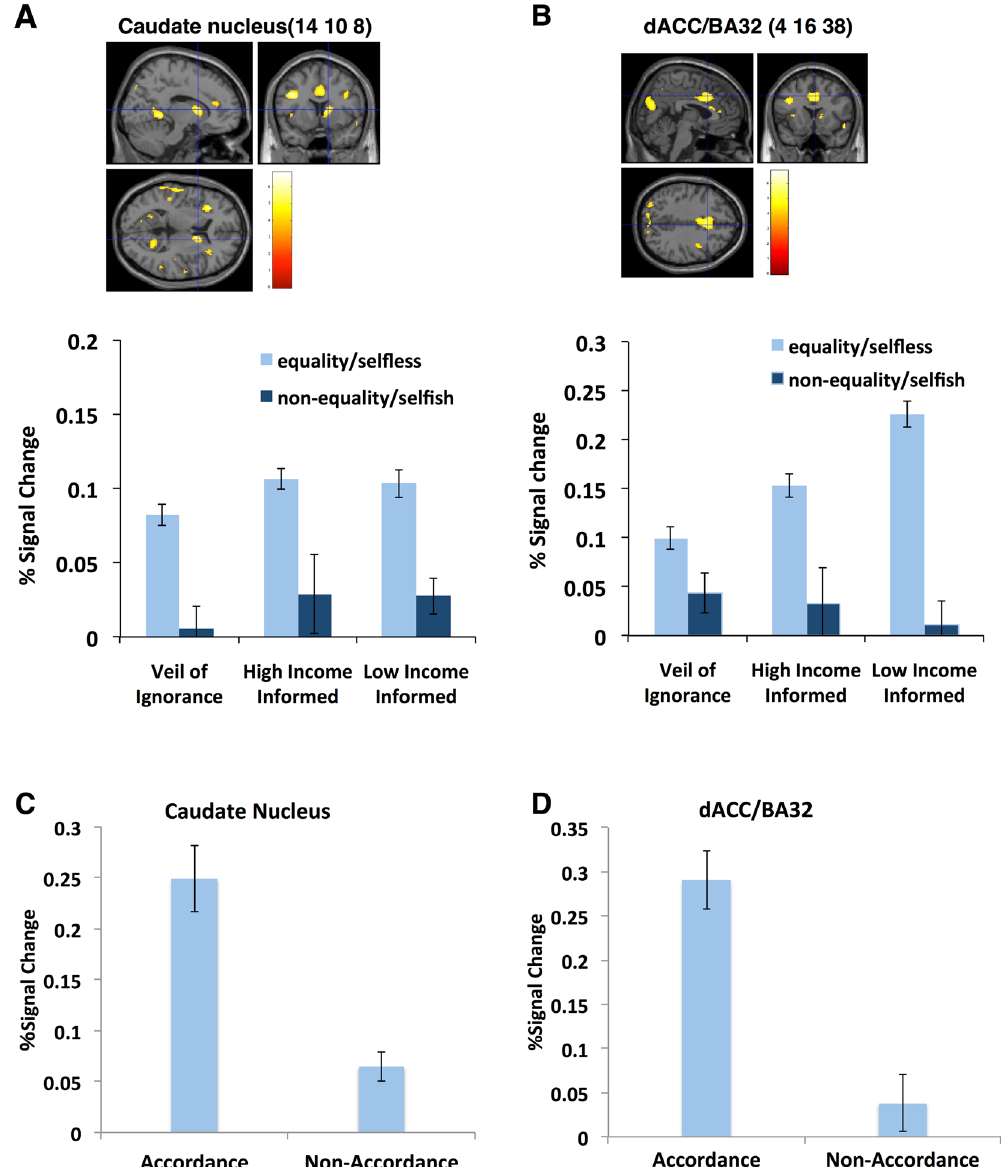
Figure 4. Panel A, B: Activation associated with an equality decision in the VoI condition but with a selfless decision in the High- and Low-income conditions. The bar plots represent the percent signal change (mean ± standard error) of the peak coordinate. Stronger activation [family-wise error (FWE)-corrected p < 0.05 for multiple comparisons across the whole brain] was associated with equality rather than non-equality decisions in the VoI condition but with selfless rather than selfish decisions when participants were informed of their high- and low-income classes, respectively. The caudate nucleus (14, 10, 8): FWE-corrected p = 0.029 for multiple comparisons across the whole brain, k = 13; the dorsal anterior cingulate cortex (dACC) (4, 16, 38), FWE-corrected p = 0.006 for multiple comparisons across the whole brain, k = 116. Neural data were obtained from the contrast in which the activation evident when drawing the lottery was subtracted from that observed upon a redistributive decision. Panel C, D: Activation in the caudate nucleus and dACC was associated with the attitude to be in accordance with others. Differential activation along with affective changes was observed only when participants had higher rather than lower income than their partners. Activation was significantly stronger in both regions ( p < 0.05, two-tailed t -test) when participants revealed the attitude to be in accordance with others, i.e., decreased affection after income disclosure towards their partners whom they came to favour during the game. The bar plots represent the percent signal change (mean ± standard error) of the peak coordinate. Neural data were obtained from the contrast in which the activation evident when drawing the lottery was subtracted from that observed upon a redistributive